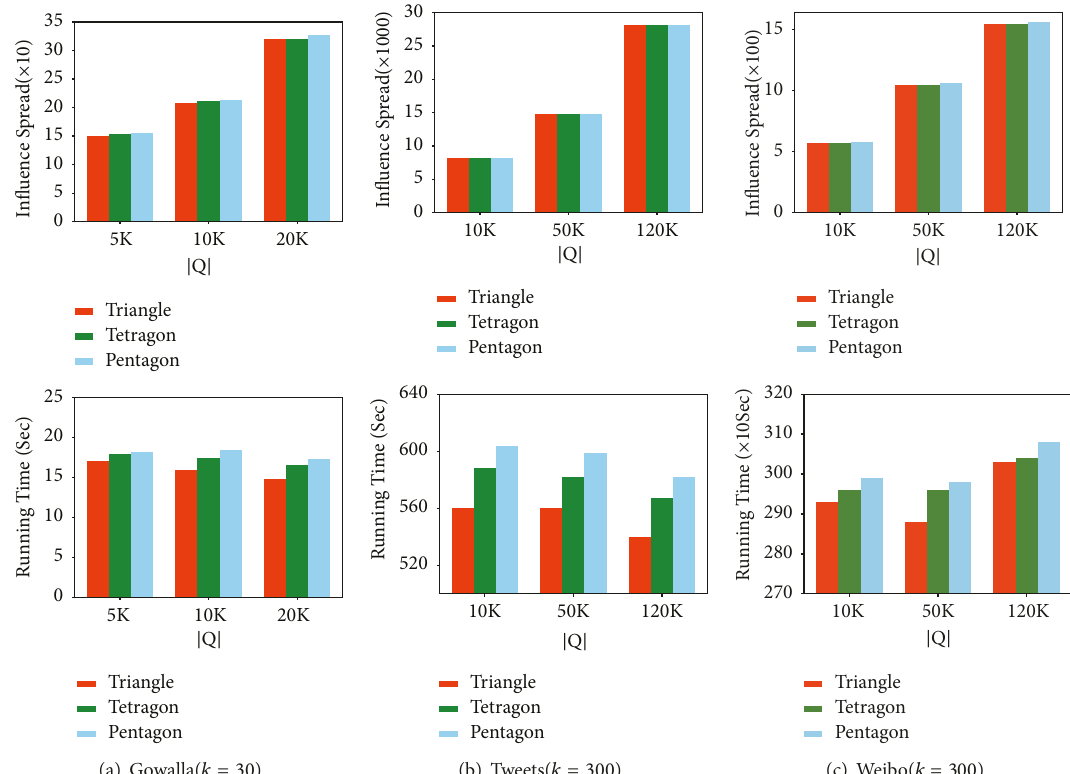
Figure 6: Influence spread and running time in terms of size and shape of 𝑄